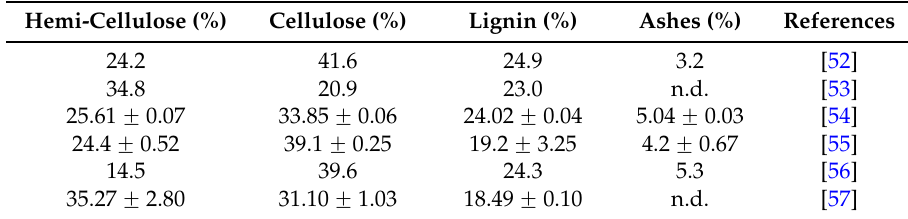
Table 2. Chemical composition of A. donax